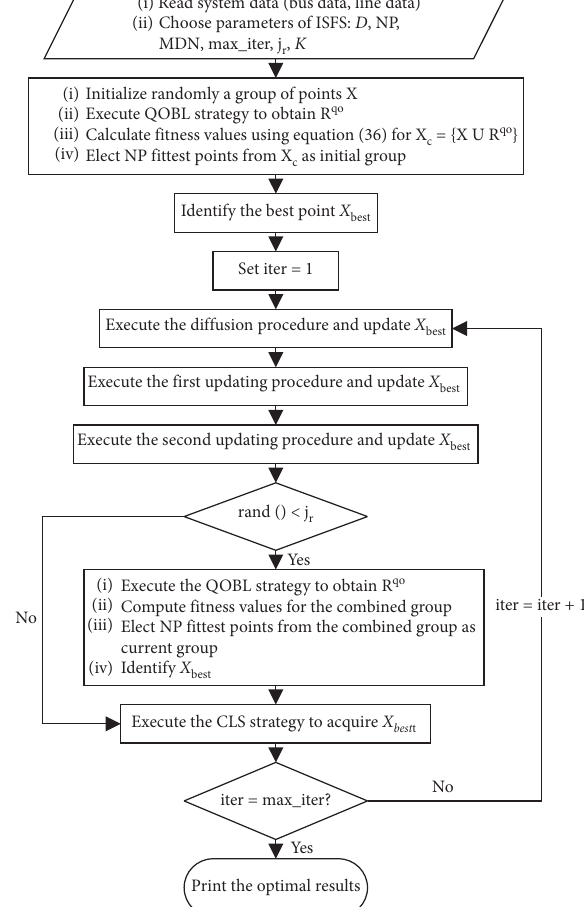
Figure 4: Flowchart of the proposed ISFS.